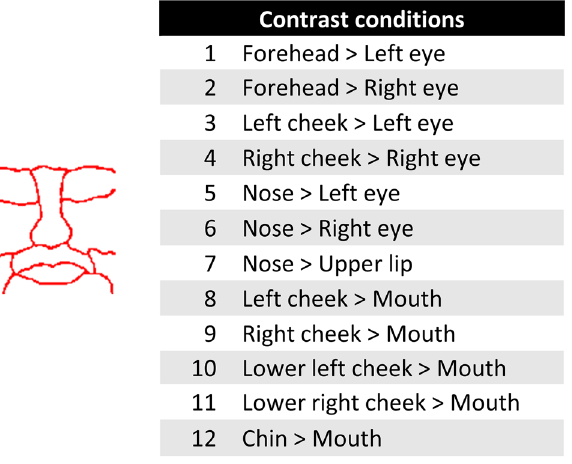
Figure 1. Template and twelve conditions of Sinha’s face detection model 5 . This template (red image on the left) is copied from Ohayon et al. 7 , their Fig. 6A. Based on this template, the twelve contrast conditions in the table on the right are created. This table is copied from Ohayon et al. 7 , their supplementary Fig. 4E.